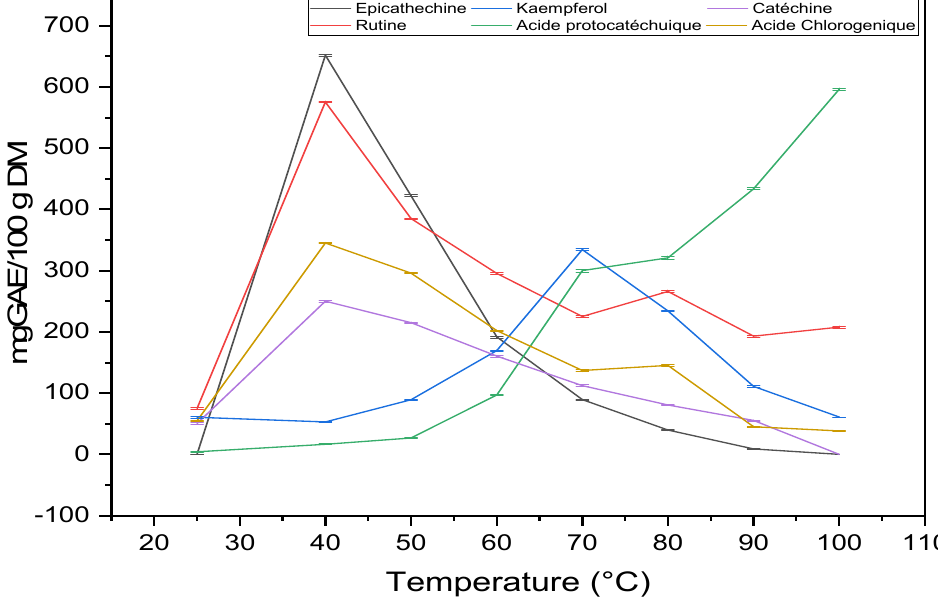
Figure 4. Degradation profile of phenolic compounds (mg/100 g DM) as a function of temperature.